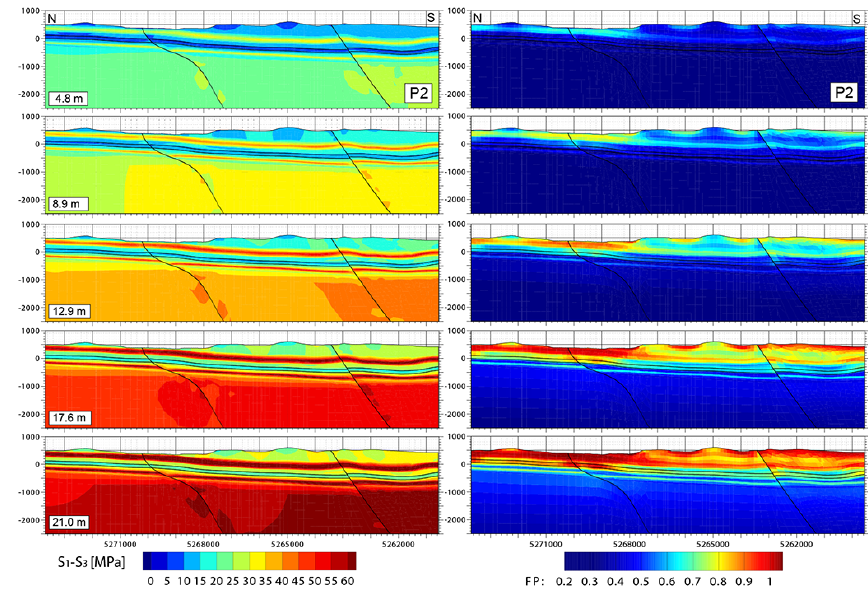
Figure 16. Additional south–north displacement of up to 21m (total 30m) and additional east and west displacement of up to 1.1m each (total 3m) of model BM in distinct steps displayed on north–south cross sections through the Weiach well. Thin black lines indicate top and bottom of the Opalinus Clay. Left column shows the gradual increase of the differential stress; right column shows the increase of the fracture potential (FP) which is the ratio of the actual differential stress to the yield stress using the plastic properties in each formation as stated in Table 1. FP values ≥ 1 indicate plastic failure of the